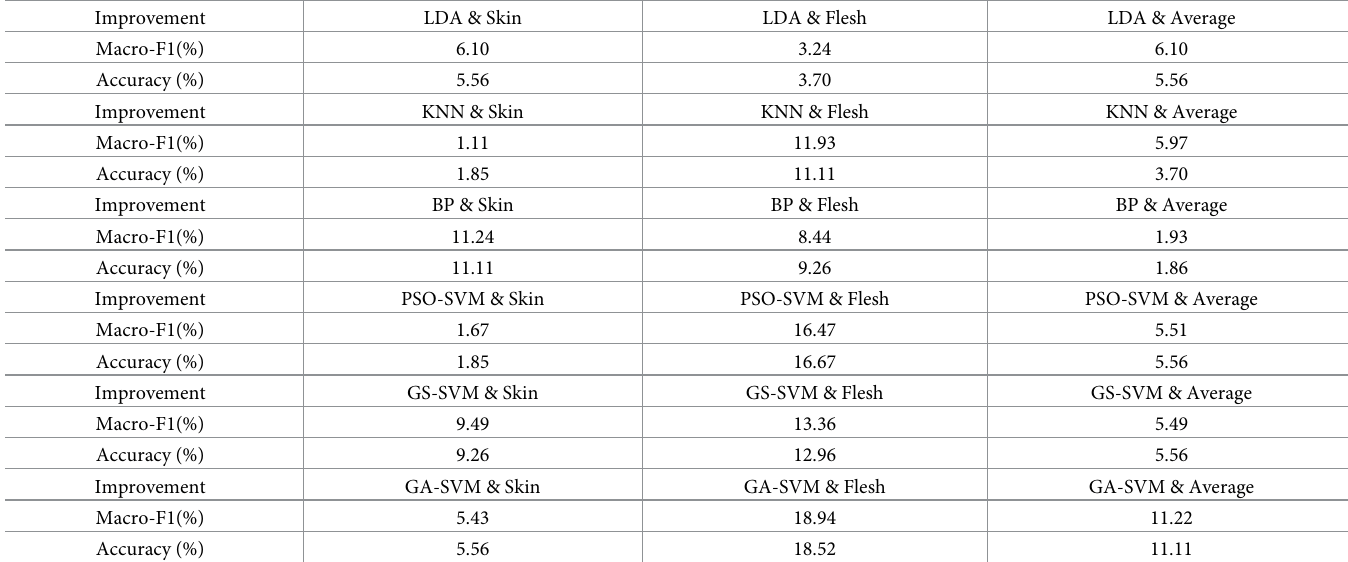
Table 3. Compared with other methods, the improvement of model with feature